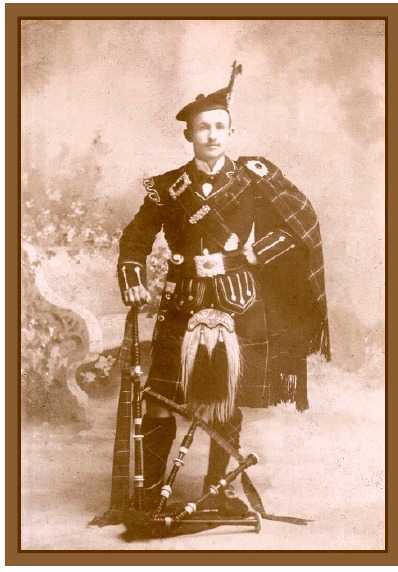
Figure 2. Angus MacMillan Fraser (1873–1938).